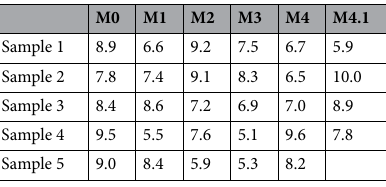
Table 1. Total number of trimmed sequences in millions generated with FastQC.